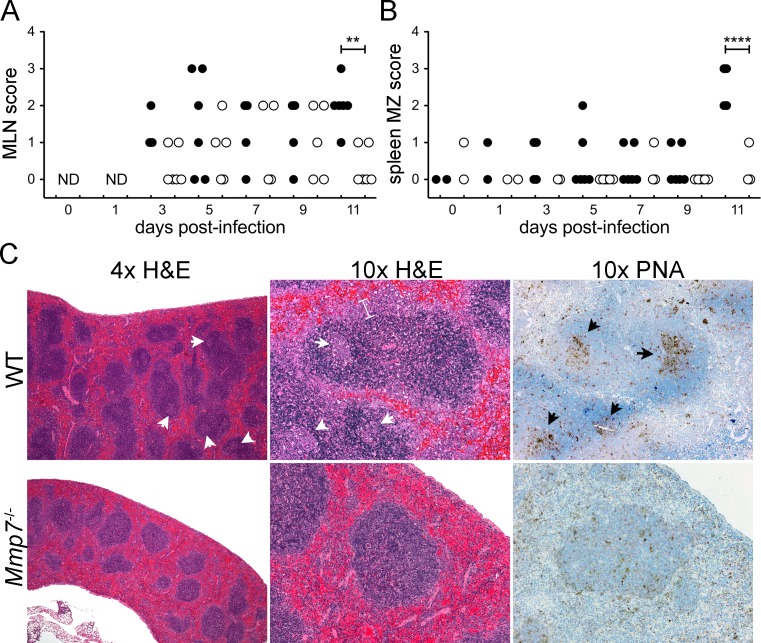
Hallmarks of adaptive immune activation in spleens and MLNs of wild type but not Mmp7
-/- mice.For the same wild type (closed symbols) and Mmp7
-/- (open symbols) mice as in Fig 4, (A) MLN follicular hyperplasia was scored on the following scale: 0, none; 1, minimal diffuse increase in cellularity; 2, mild enlargement with 1–2 small germinal centers; 3, >2 germinal centers. (B) Splenic marginal zone hyperplasia was scored on the following scale: 0, none; 1, 1.5× normal; 2, 2× normal and readily observable at 4× magnification; 3, 3× normal; 4, >3× normal. (C) Representative H&E and peanut agglutinin (PNA) stained sections from infected mice of each genotype on day 11 p.i. at 4x and 10x magnification. PNA stained sections are counterstained with hematoxylin. Examples of prominent germinal centers (arrowheads) and thickened marginal zone (bracket) in the wild type sample are marked. **P = 0.001–0.01 and ****P<0.0001.